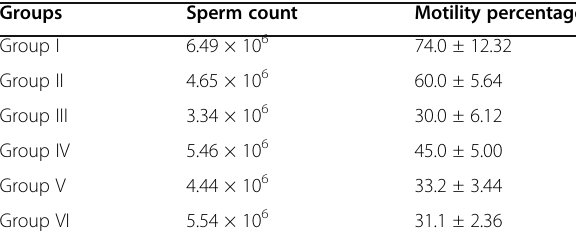
Table 2 Sperm analysis or andrological parameters of albino rats in all groups under study